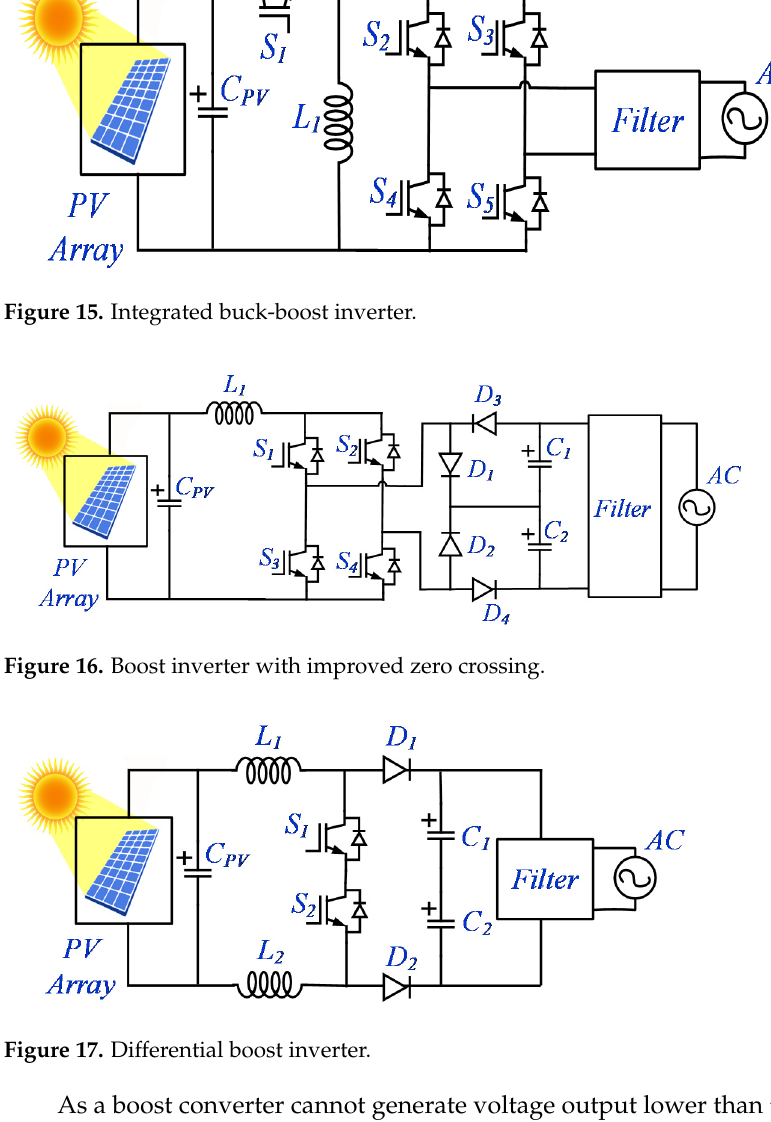
Figure 14. Integrated boost inverter .